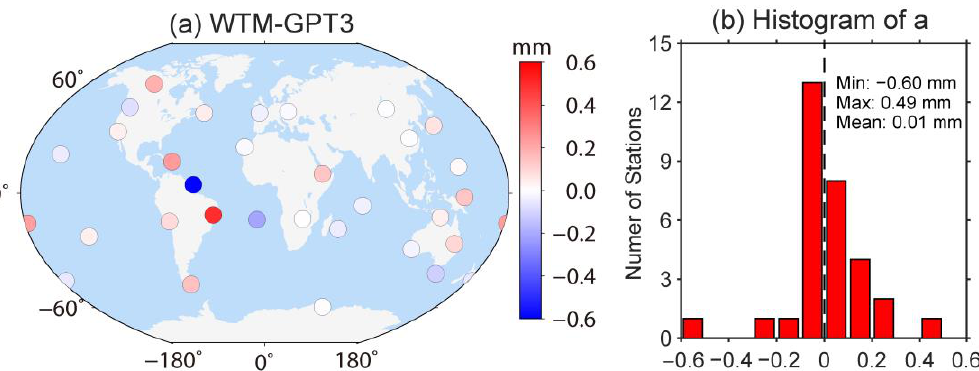
Figure 8. Distribution ( a ) and histogram ( b ) of the coordinate repeatability difference between the two PPP schemes.